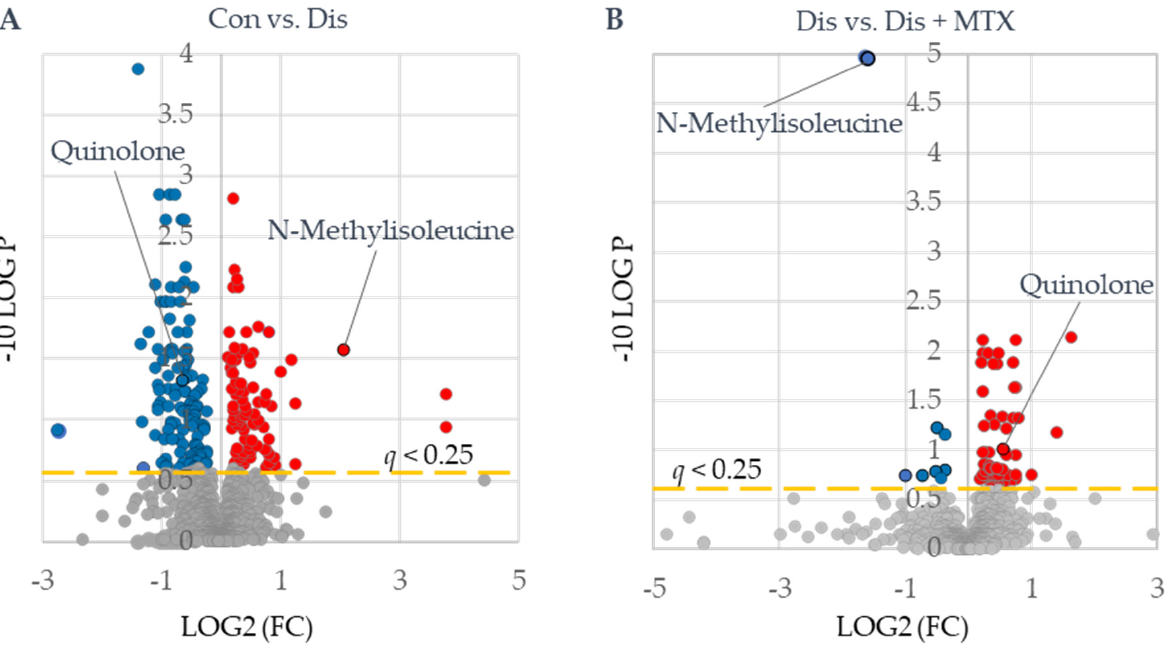
Figure 4. Identification of metabolites of interest associated with CIA disease induction and MTX therapy. Plasma metabolomics data were subjected to univariate analysis using MetaboAnalyst 5.0 providing volcano plots for ( A ) control (Con) ( n = 10) vs. disease mice (Dis) ( n = 8) and ( B ) disease mice (Dis) ( n = 8) vs. disease mice treated with MTX (Dis + MTX) ( n = 9). Red-colored metabolites were found to increase, and blue-colored metabolites were found to decrease ( q < 0.25).